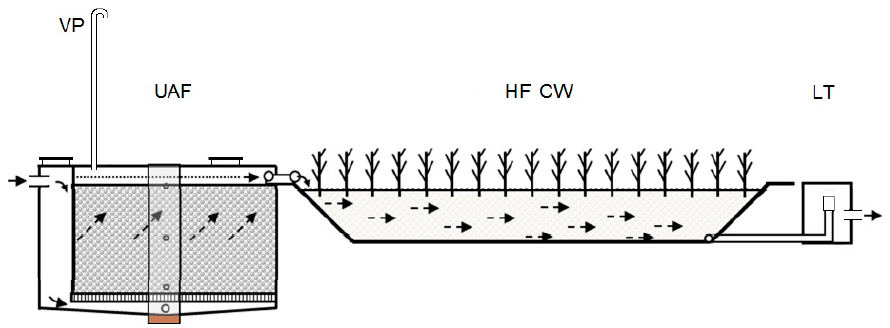
Figure 3. Wastewaters flowing to an up-flow anaerobic filter (UAF) and then to a horizontal subsurface constructed wetland (HF CW).